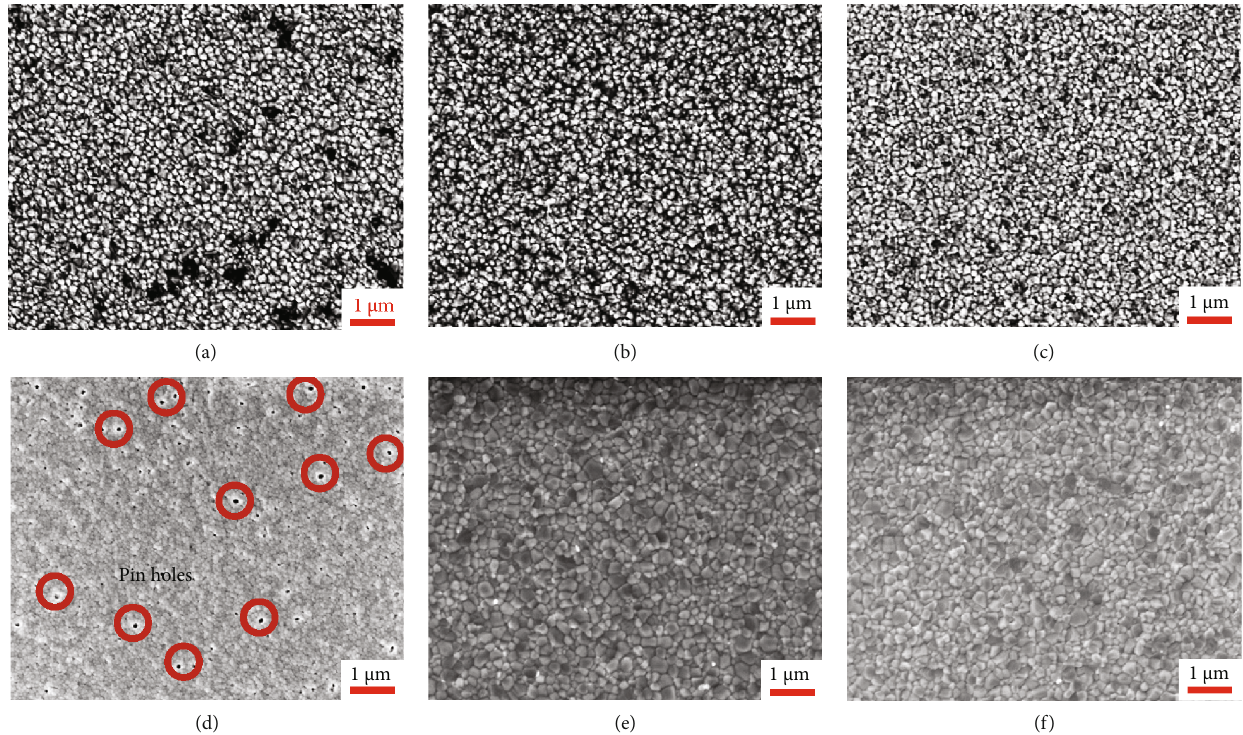
Figure 2: The top view morphologies of (a) NiOx annealed at 100 ° C, (b) NiOx annealed at 300 ° C, and (c) NiOx at 500 ° C. The top view morphologies of perovskite fi lms deposited on (d) NiOx annealed at 100 ° C, (e) NiOx annealed at 300 ° C, and (f) NiOx at 500 °